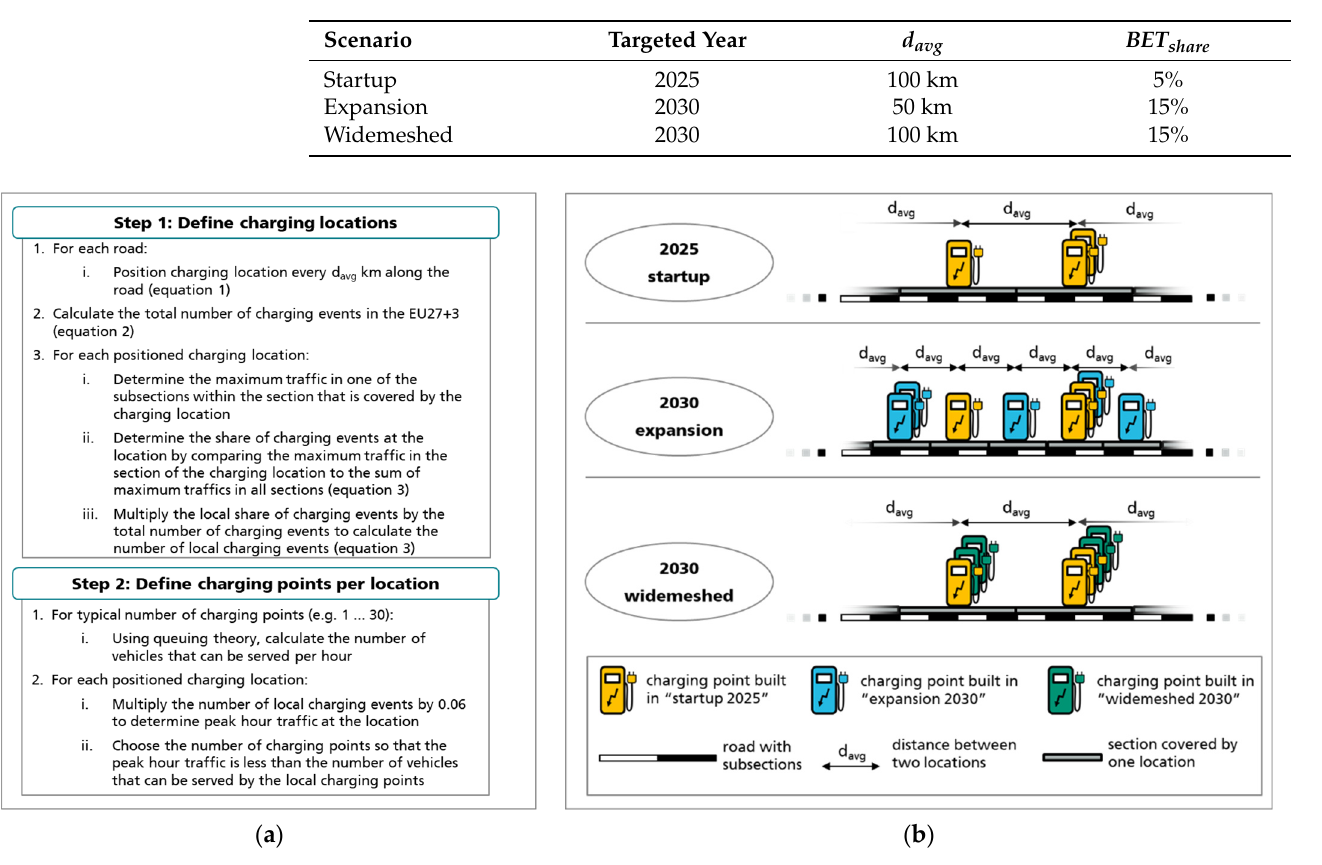
Table 1. Input parameters for infrastructure calculation.